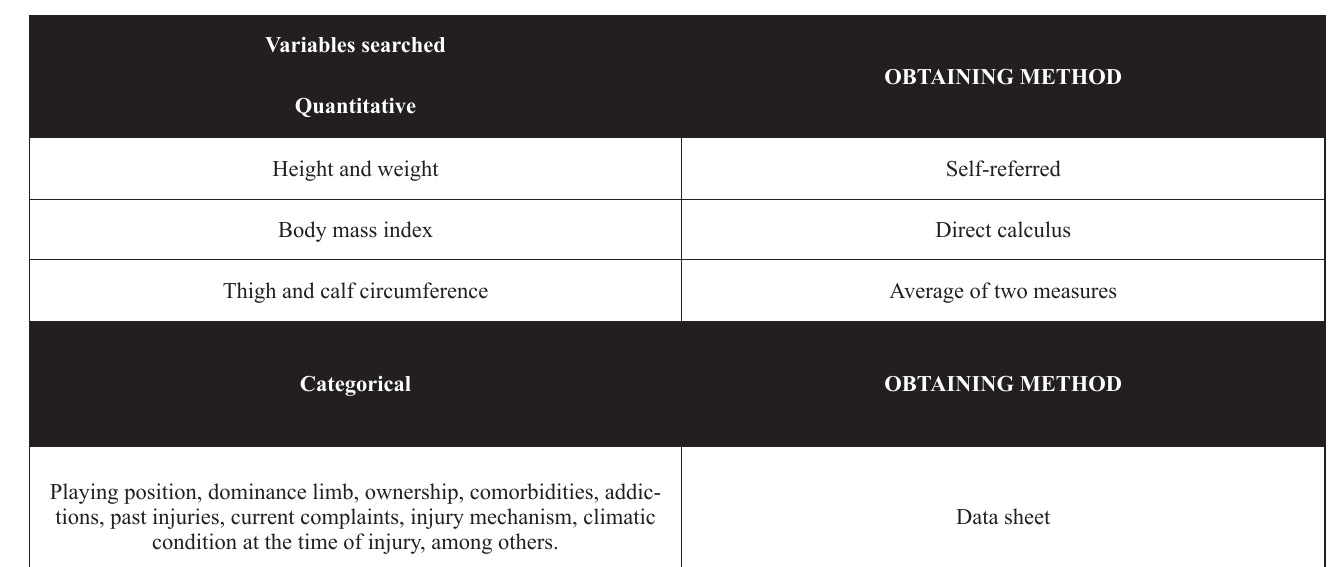
Figure 1. Variables searched and obtaining